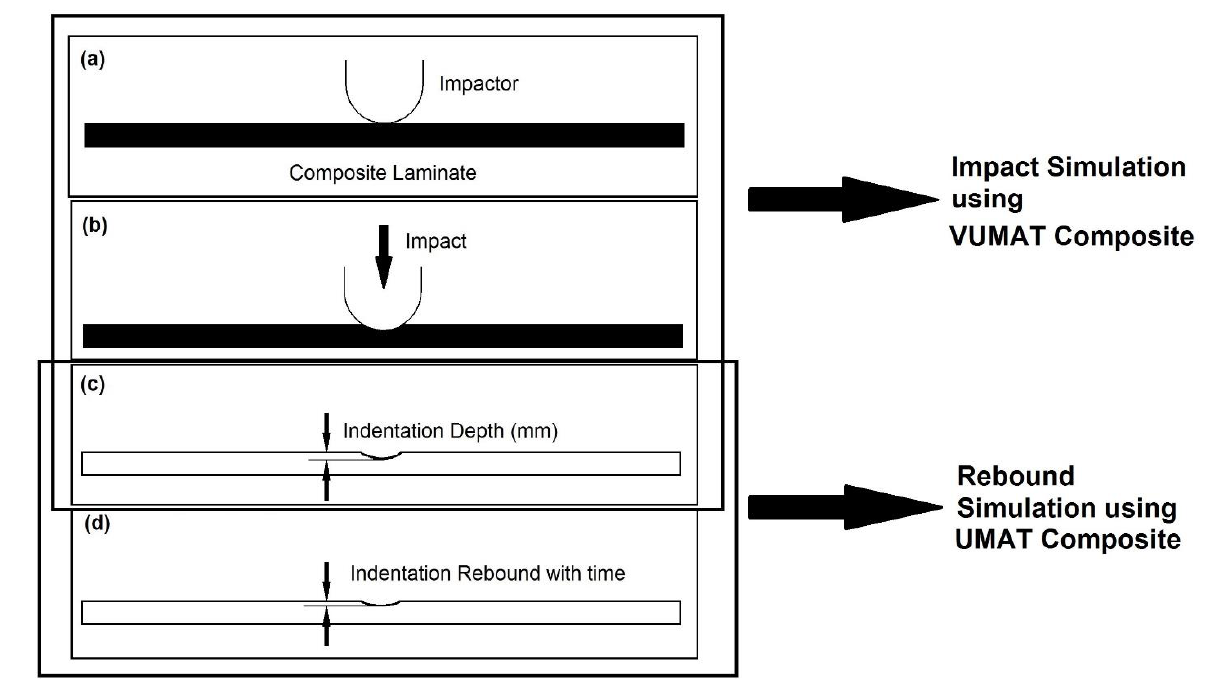
Figure 10. Simulation methodology: LVI with initial indentation depth and its rebound with time: ( a ) before impact; ( b ) impact dent; ( c ) initial dent depth; ( d ) final dent depth. Firstly, impacts at different energy levels (30 J, 40 J, and 50 J) were simulated in